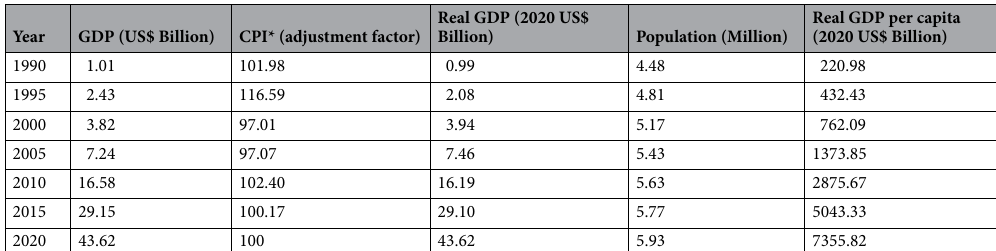
Table 4. Population and real per-capita GDP in